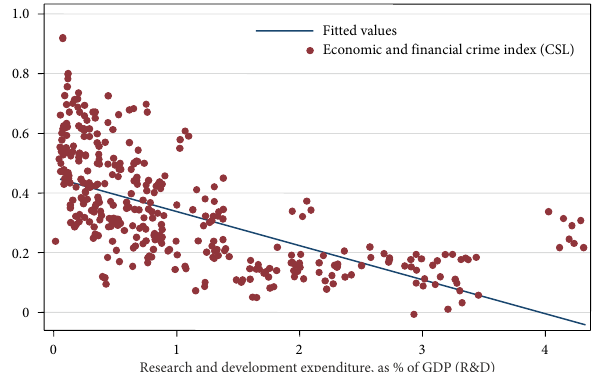
Figure 1. Plots of Economic and financial crime index (CSLindex) against technology expressed as Research and development expenditure, as % of GDP (R&D)